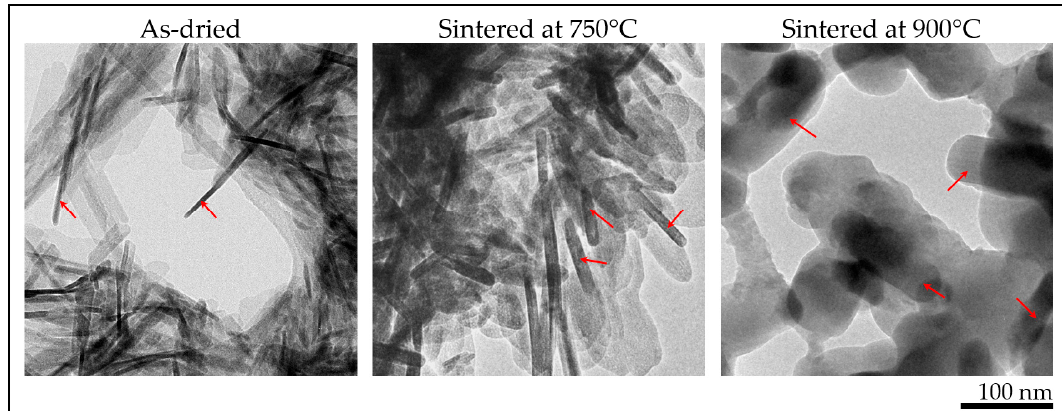
Figure 8. Bright-field TEM micrographs of the as-dried and sintered samples, which were synthesized at pH 5.5. After sintering at 750 °C, pure β -TCP is obtained, keeping its initial as-dried morphology with slightly thicker needle-like structures.